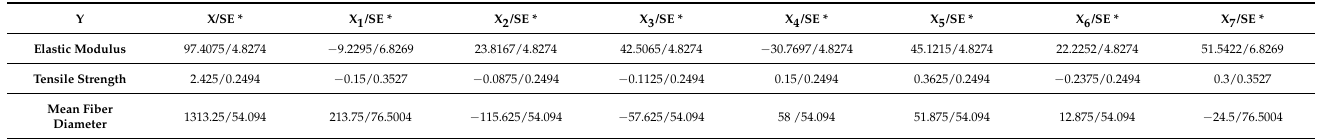
Figure 5. The optimal solution for maximizing the mechanical properties and MFD values of an electrospun composite membrane.